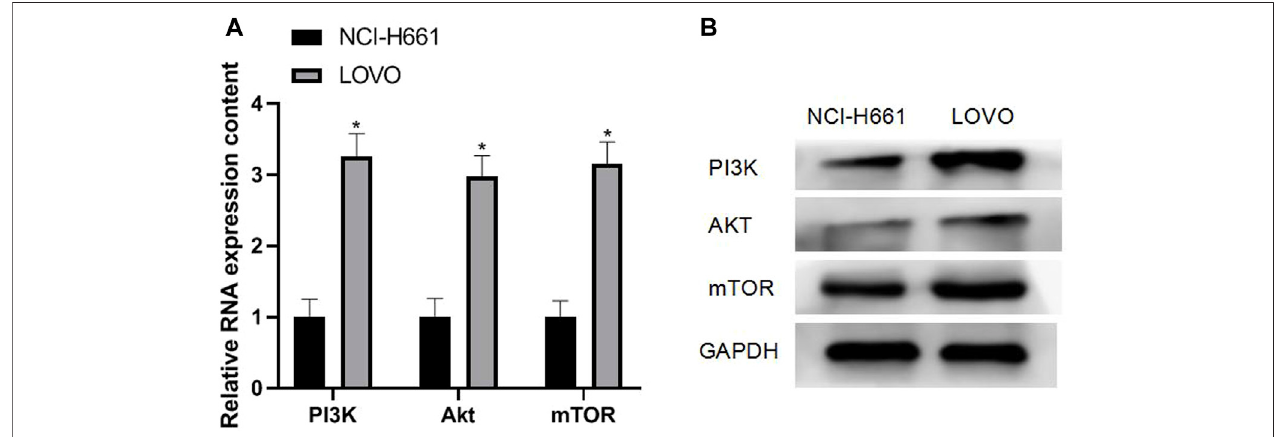
FIGURE 1 | Expression of PI3K/Akt/mTOR in CRC cells. Note: (A) qRT-PCR experiment; (B) Western blotting experiment, compared with NCI-H661, * p < 0.05.